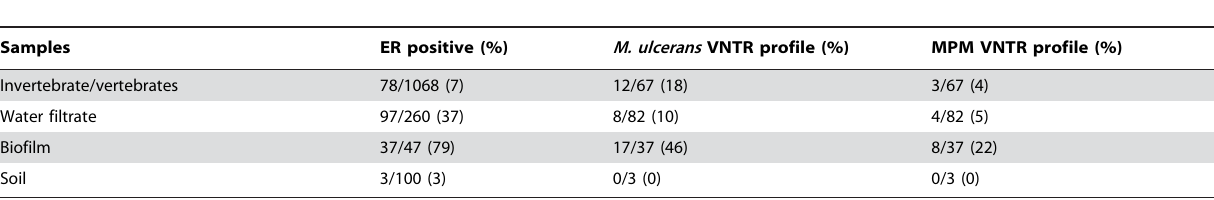
Table 4 . Detection of M. ulcerans and MPM in environmental samples using ER and VNTR PCR.